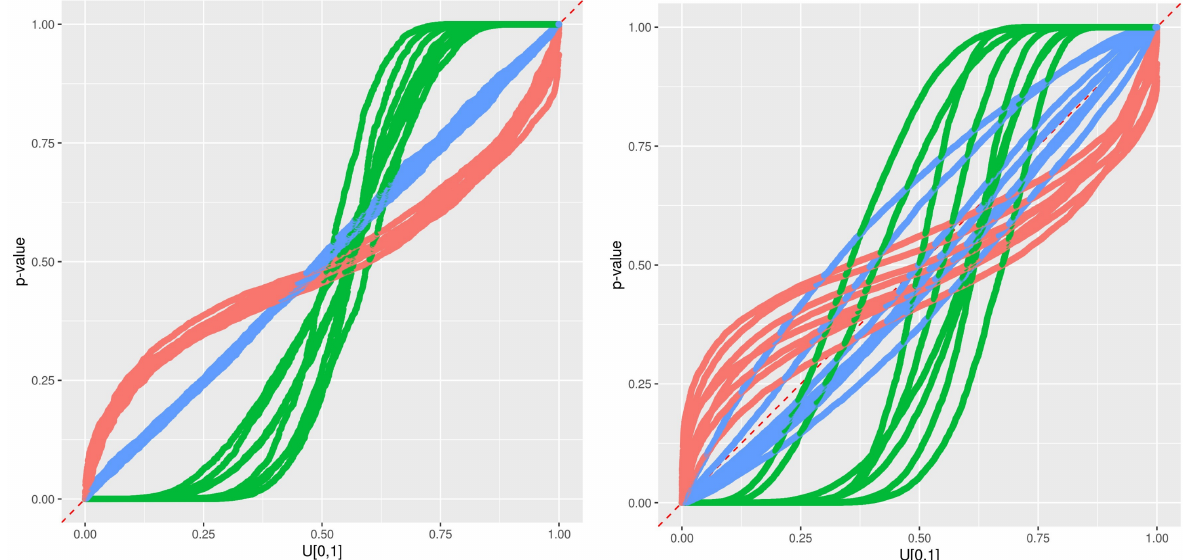
Figure 7. Predictive qq-plot for the training/testing period 2017–2018 ( left ). Predictive qq-plot for the validation period 2015–2016 ( right ). The different methods are colored in red for Eaamm 2010, green for Wager 2014 and blue for Lu 2019. Each curve corresponds to one